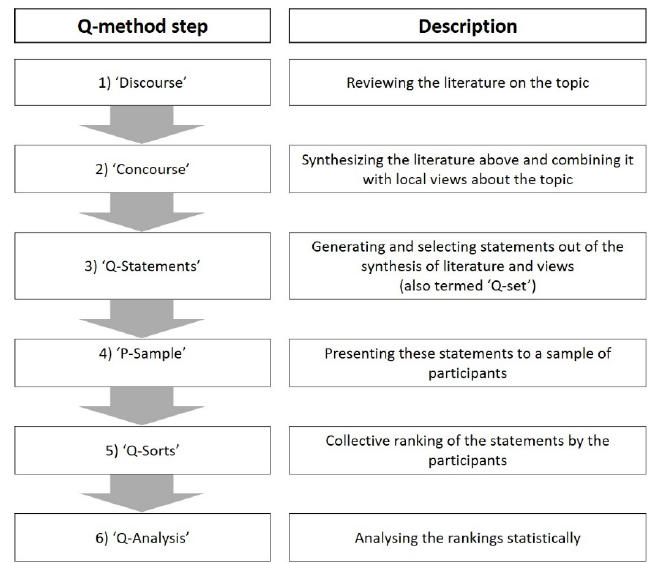
Figure 2. Stages of the Q-method approach used in this study, including steps and procedures (based on [62]; see also [45,48–50]).